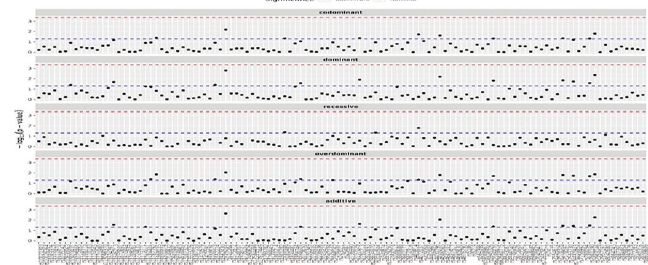
Figure 2 - Graphical representation of p values (p.value) in phenotype-genotype associations